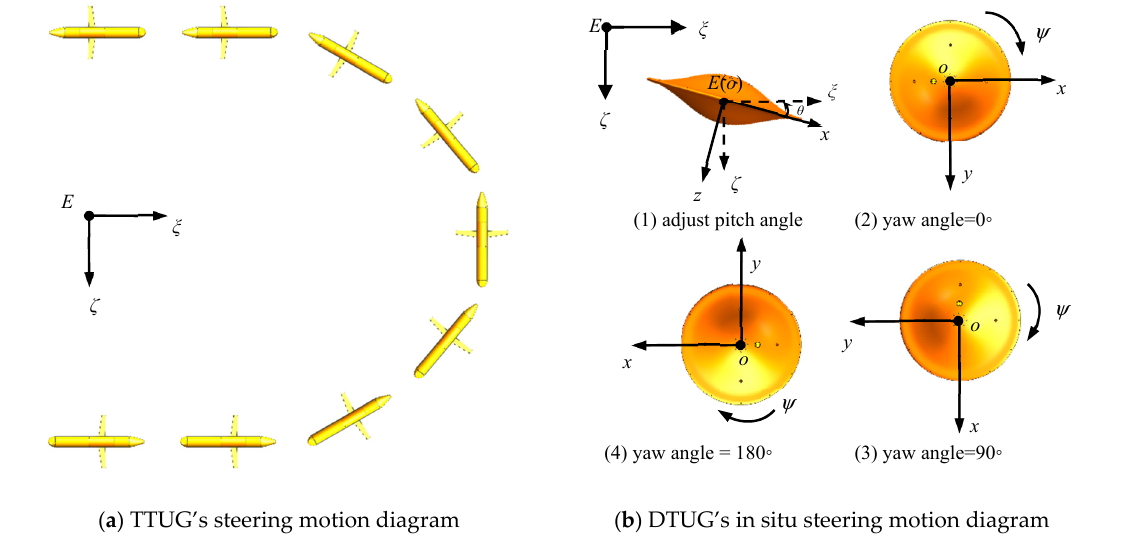
Figure 7. TTUG (torpedo-type underwater glider) and DTUG steering motion diagram.